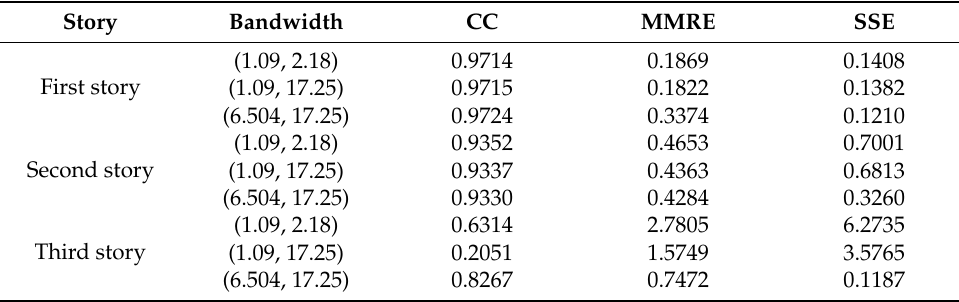
Table 7. Error analysis of PA versus smartphone for the damaged